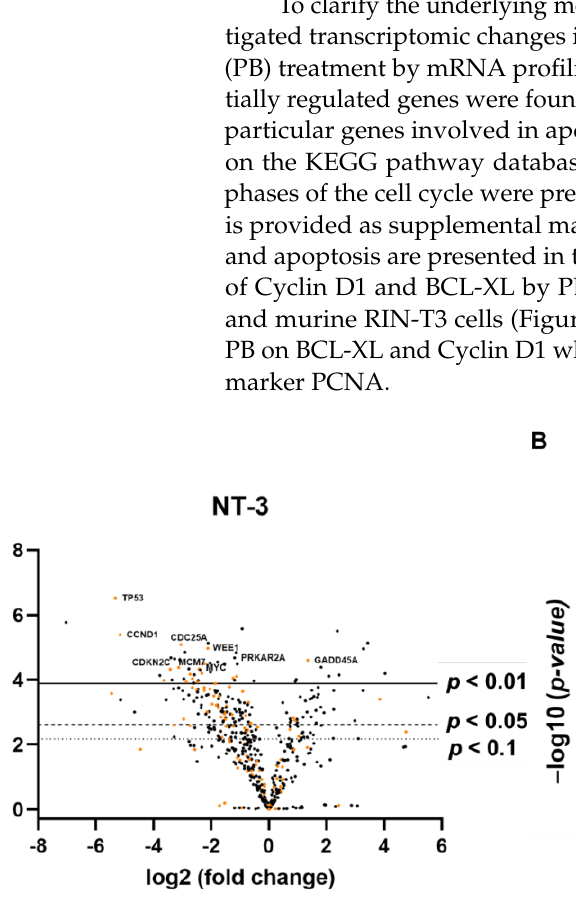
Figure 4. Regulation of genes by panobinostat in NT-3 and NT-18LM cells. Cells were treated for 48 h by panobinostat and analyzed by nCounter mRNA expression array. Triplicates were created and DMSO treatment served as control. ( A , B ): Volcano plot of the entire gen panel. Genes involved in apoptosis and cell cycle (top 10) are displayed in the representative figure. Changes in the expression compared to the control are presented in a logarithmic scale (x-axis). The y-axis demonstrates the significance. The corresponding raw data are available as supplemental material (Supplementary Material S1–S4).